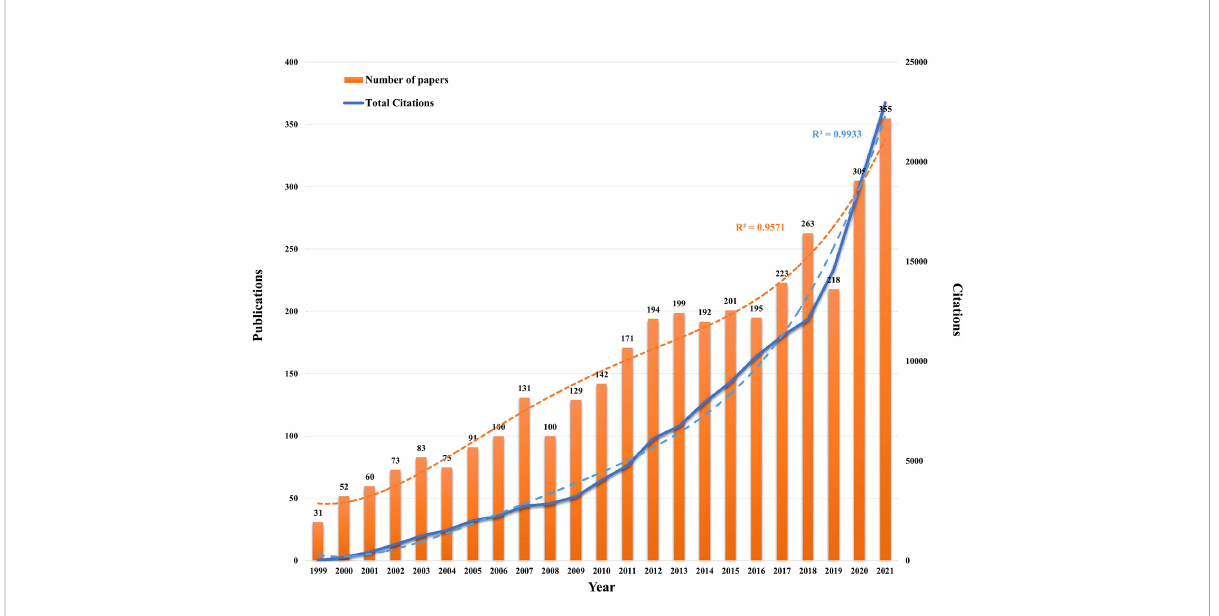
FIGURE 2 Annual trend and polynomial fi tting curve of published articles and citations in the fi eld of PCa immunotherapy in the database of WoSCC from 1999 to